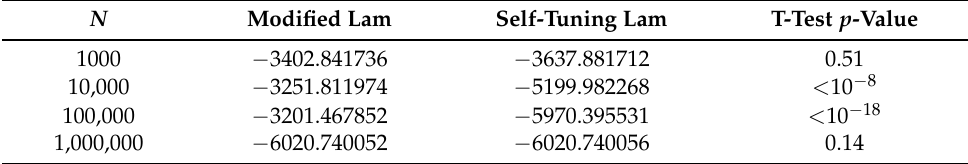
Table 10. Average solution for minimizing f 1,1000 ( x ) . The minimum is f 1,1000 ( x ) ≈ − 6020.74.